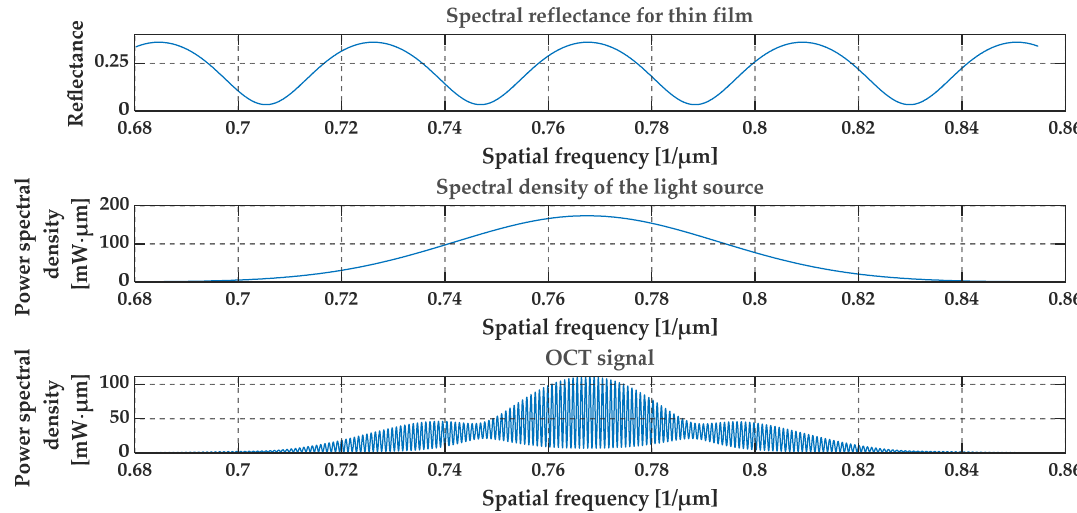
Figure 7. Theoretical spectral characteristics obtained from a thin film of diamond. The thickness of the film is 5 µm and the depth of the layer is 0.25 mm. Refractive indexes are n 1 = 1, n 2 = 2.4, n 3 = 1.45.